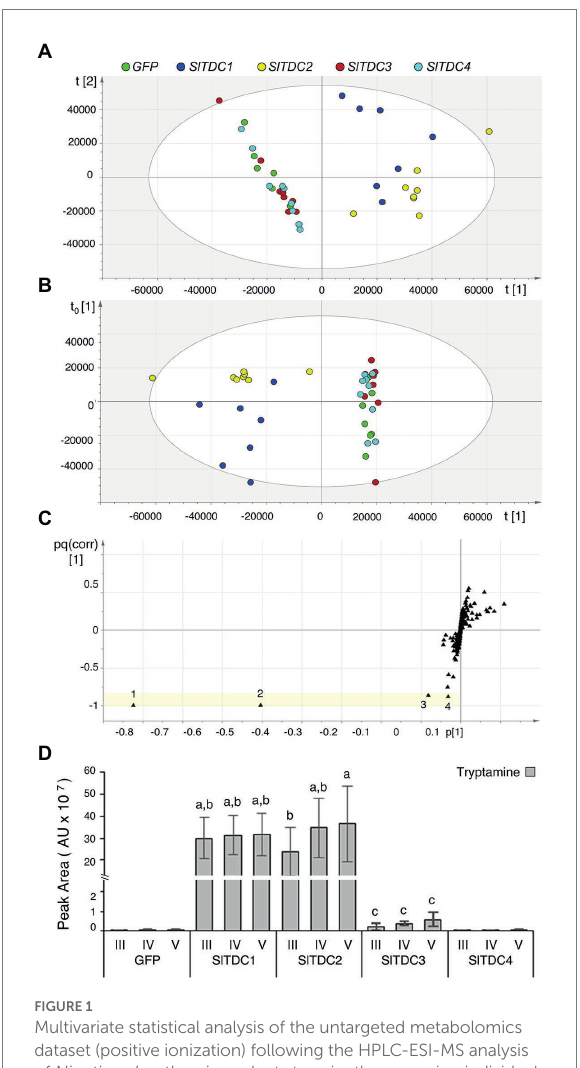
FIGURE 1 Multivariate statistical analysis of the untargeted metabolomics dataset (positive ionization) following the HPLC-ESI-MS analysis of Nicotiana benthamiana plants transiently expressing individual SlTDC genes or GFP as a negative control. (A) PCA score scatter plot. (B) OPLS-DA score scatter plot. (C) OPLS-DA S-loading plot, with each metabolite represented by a black triangle. The yellow area highlights metabolites characteristic of the SlTDC1/SlTDC2 cluster but not the GFP / SlTDC3 / SlTDC4 cluster: 1 and 2 represent molecular and fragment ions of tryptamine (161 and 144 m/z , respectively), 3 is a molecular ion of serotonin (177 m/z ), and 4 is an unidentified metabolite (177 m/z ). (D) Levels of tryptamine in the infiltrated leaves. AU = arbitrary unit. Data are means ± standard deviations ( n = 3). Different letters on bars indicate that means are significantly different according to post-hoc Tukey-ANOVA ( p <